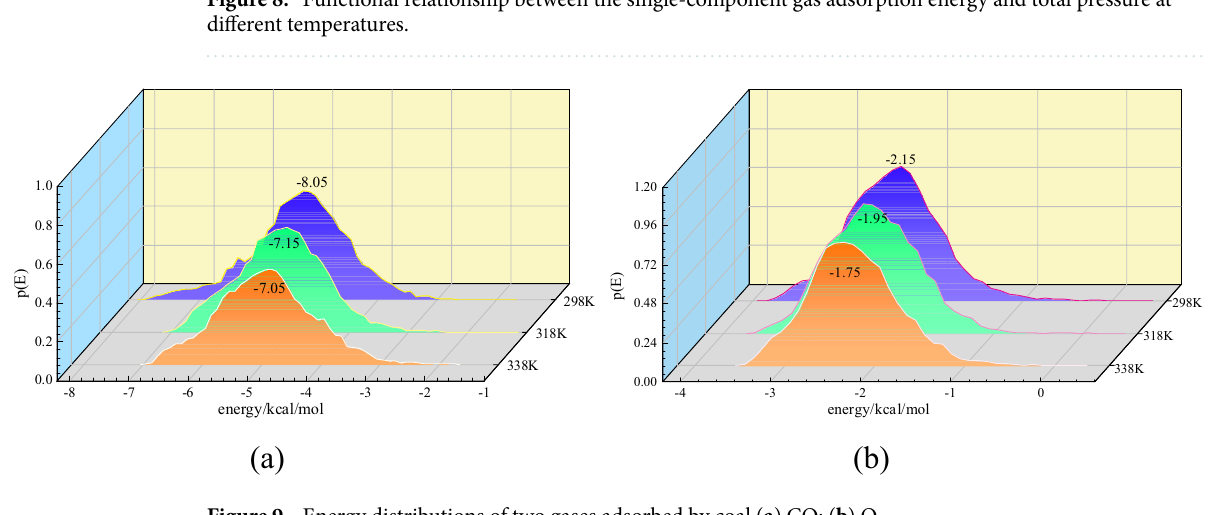
Figure 9. Energy distributions of two gases adsorbed by coal ( a ) CO; ( b ) O 2